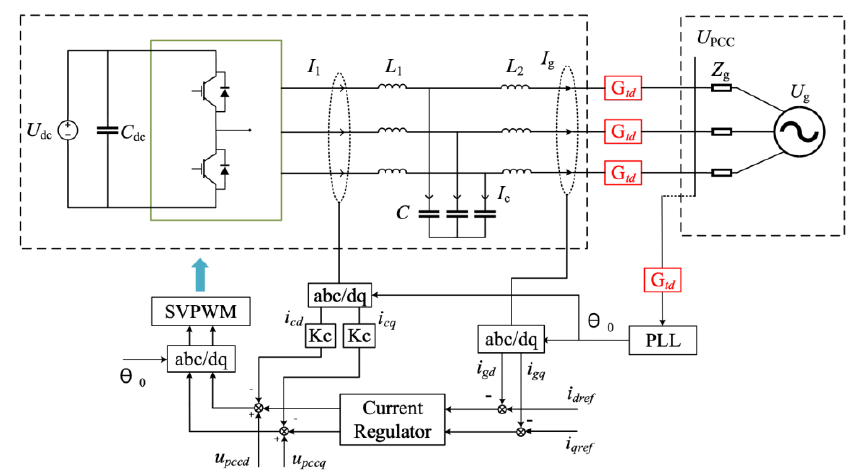
Figure 6. The topology structure of the LCL grid-connected inverter.